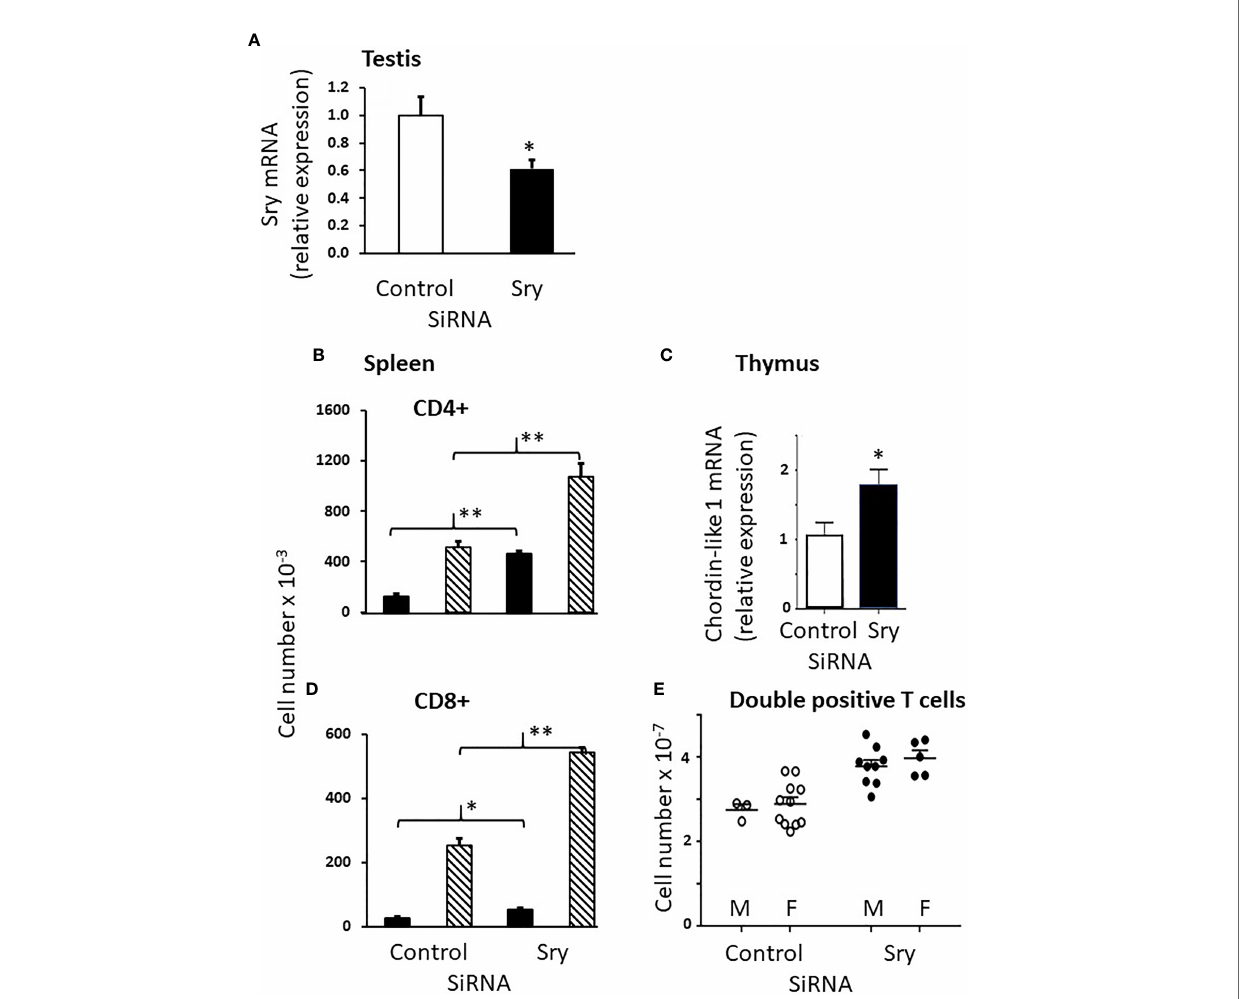
FIGURE 11 | Use of the SiRNA for Sry had similar effects in male and female FCG pups. Knockdown of Sry within the male testes was con fi rmed (A) , but both male and female animals showed an increase in both CD4+ and CD8+ cells in the spleen as a consequence of treatment (B, C) . Use of the Sry SiRNA raised expression of chordin-like 1 (D) and increased the number of double positive cells in the thymus of treated animals (E) . Mouse pups were treated with the Sry or control SiRNA between days 1 and 7 postpartum before collection of tissues. Data are presented as the mean ± SD and are derived from 3 males and 11 females for control SiRNA treatment groups and 9 males and 5 females for Sry SiRNA treatment groups. Males (solid bars in B , C ); Females (cross-hatched bars in B , C ). Different from control SiRNA *p < 0.05; **p <